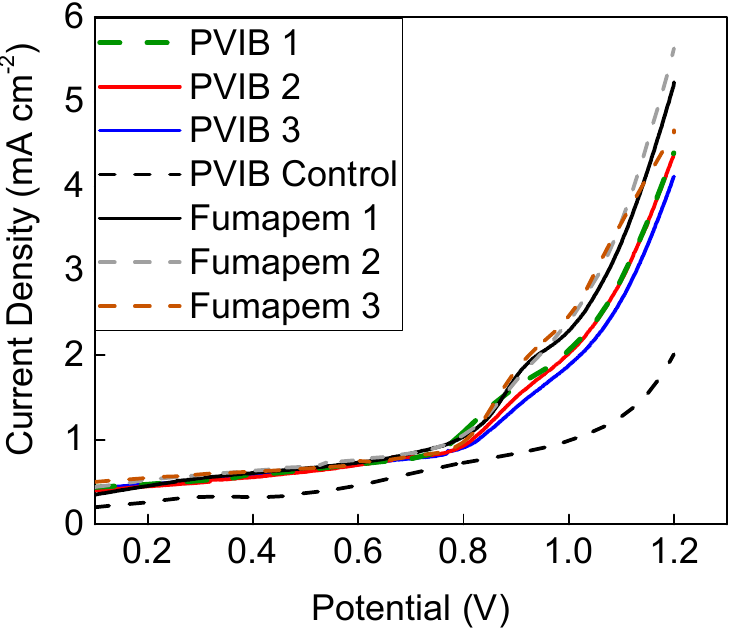
Figure 6. Polarisation curves at 70 °C showing the behaviour of electrolysers using commercial Fumapem and PVIB-10 with an anolyte feed of 1 M NaOH containing 10 g L − 1 alkali lignin. The green-dashed line, solid red line and solid blue line show three repeat traces for the PVIB-10 membrane, and the black solid line, grey-dashed line and brown-dashed line show three repeat traces for the Fumapem membrane. A control for a PVIB-10-based system using only 1 M NaOH at 70 °C as the anolyte is also provided as the black-dashed trace.